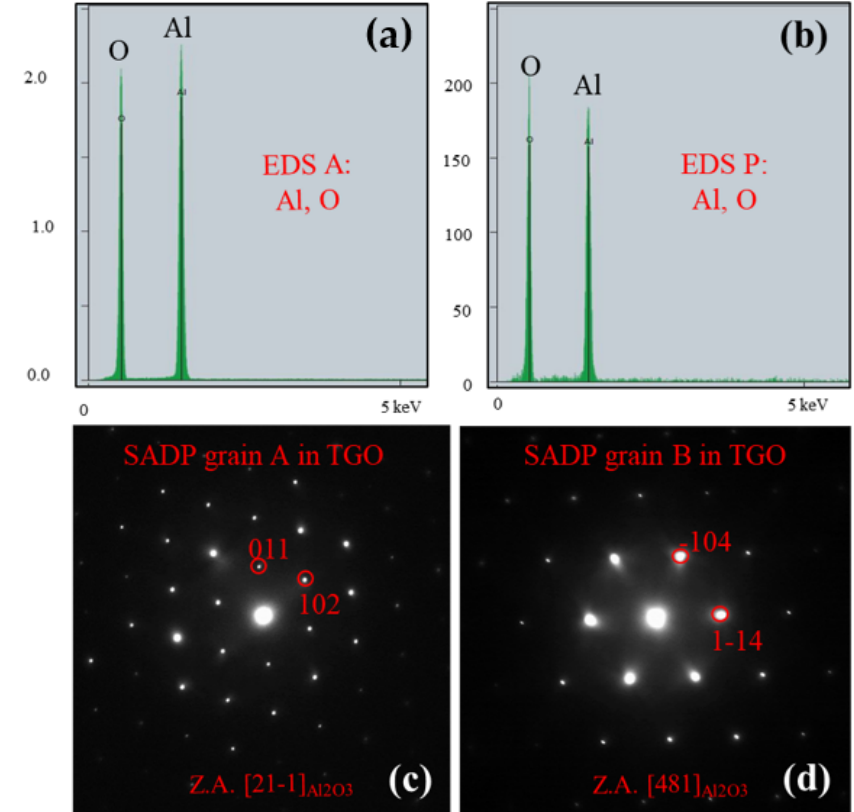
Figure 12. EDS spectra of ( a ) TGO grain (A) and ( b ) imbedded particle (P) in Figure 11. ( c ) hkl [21–1] and ( d ) [481] Z.A. SADP of TGO grains (A) and (B) in Figure 11. Hexagonal Al 2 O 3 : a 0 = 4.8 Å, c = 12.9 Å.